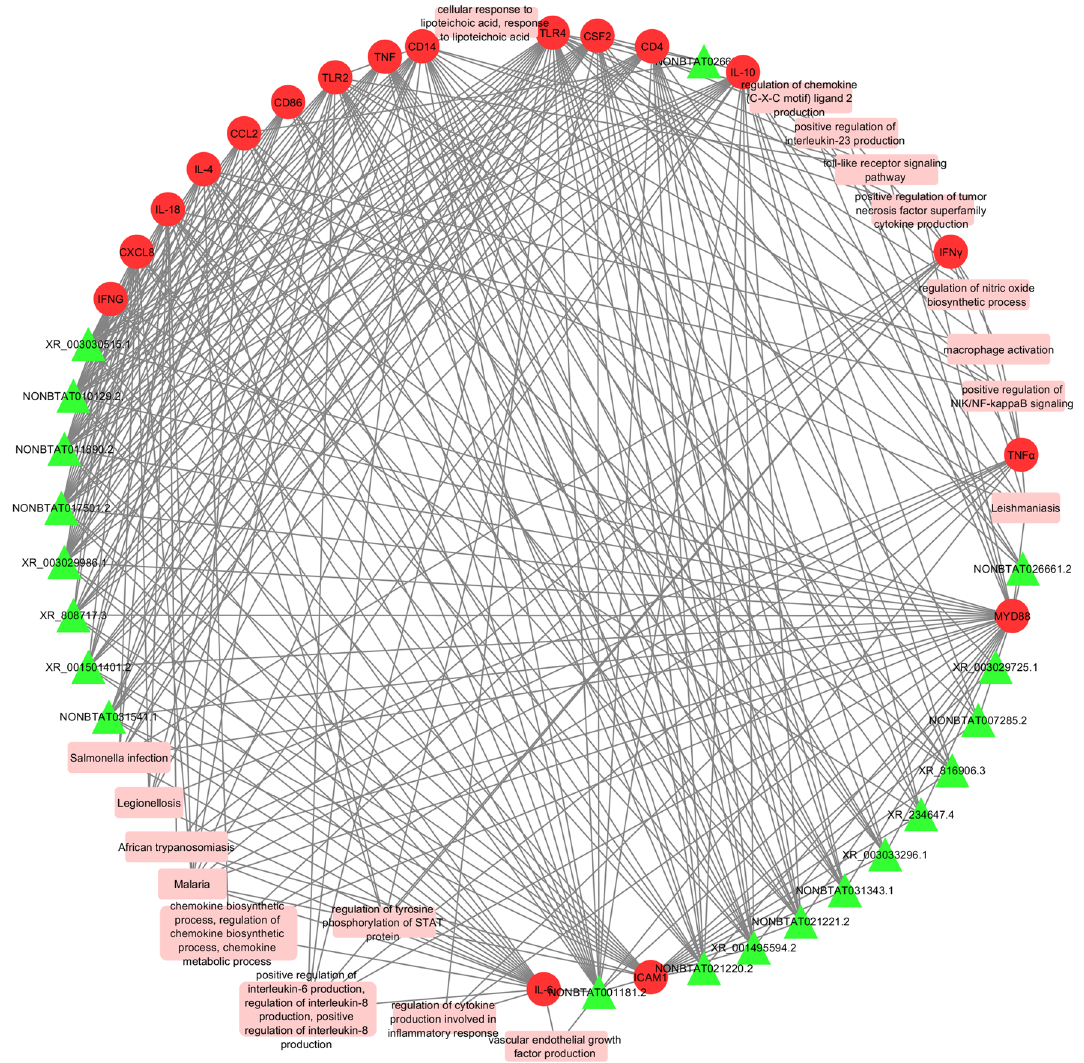
Figure 9. A network incorporating lncRNA, their target genes and corresponding gene ontologies. The green triangles are the lncRNA, red circles represent the target bovine mastitis genes, and the pink rectangles are the biological processes, molecular functions, cellular components, and pathways (Cytoscape version 3.7.2; https:// cytos cape.